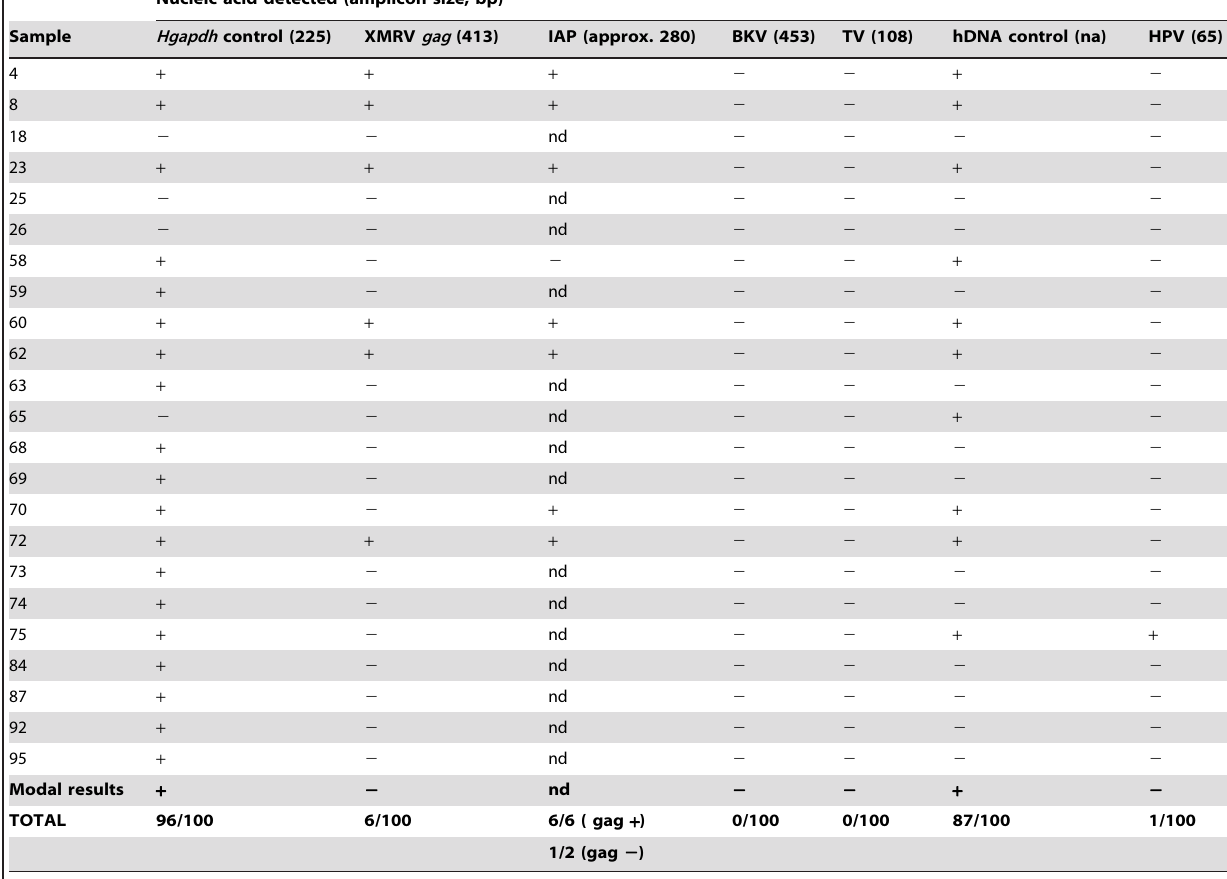
Nucleic acid detected (amplicon size,